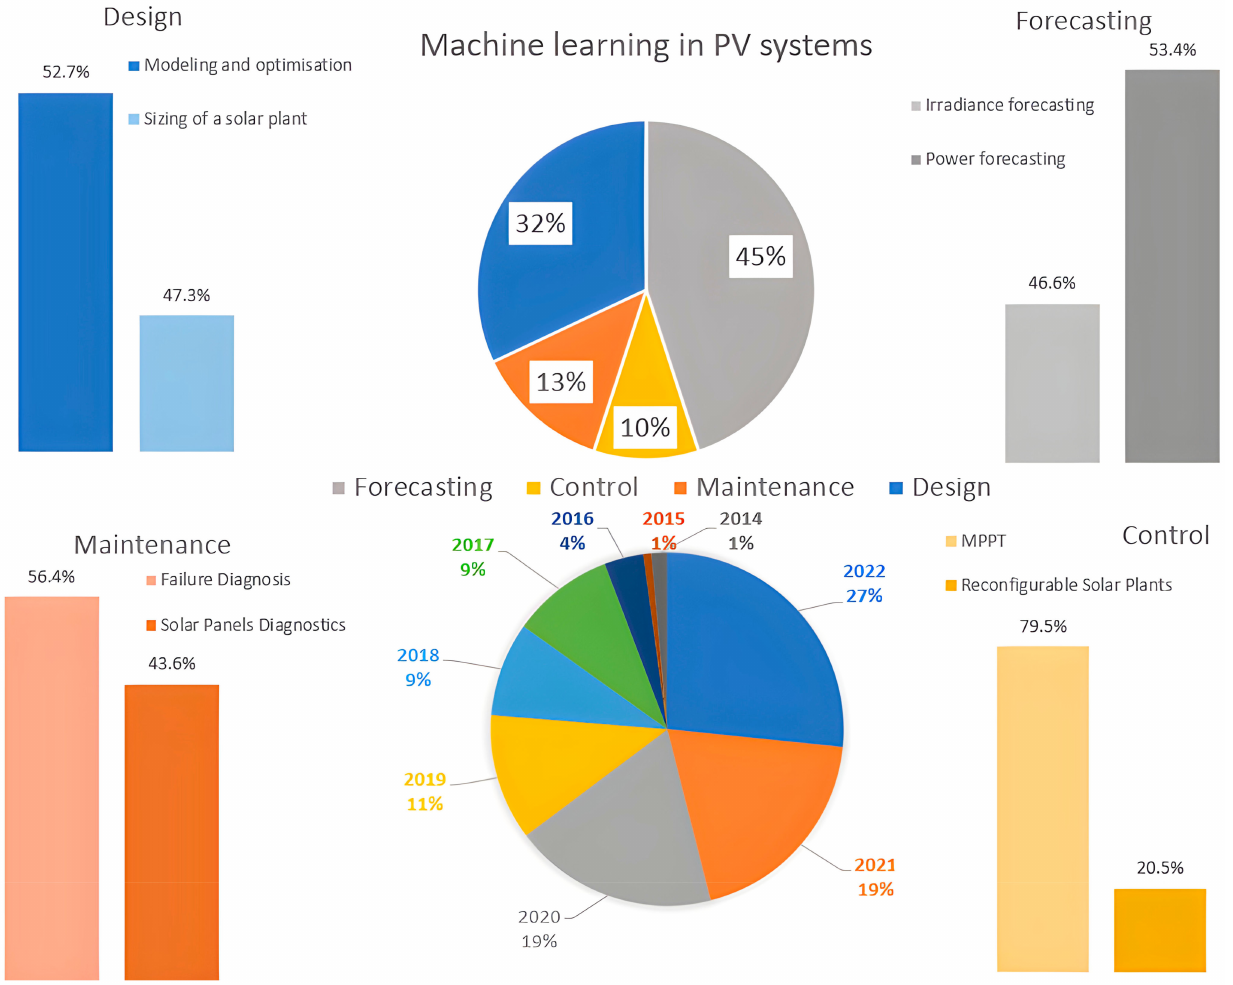
Figure 3. ML technologies for a solar plant’s design, forecasting, maintenance, and